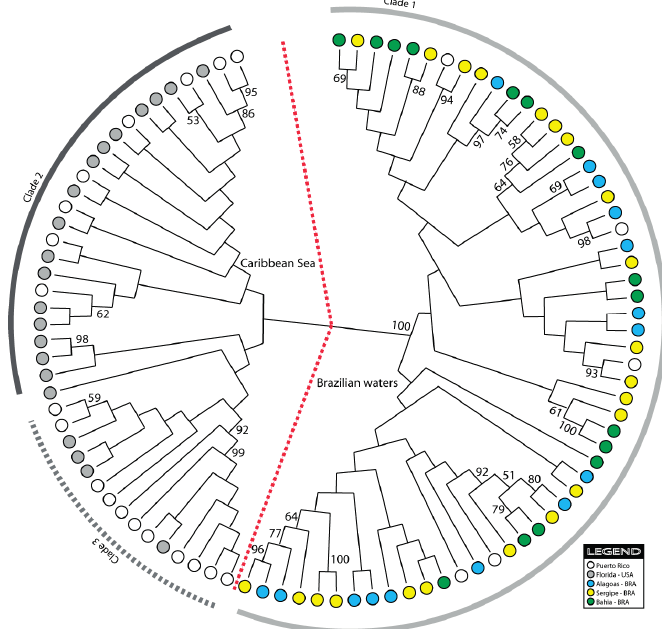
Figure 2. Neighbor-joining phylogenetic tree of the 93 C. guanhumi haplotypes collected from five sampling